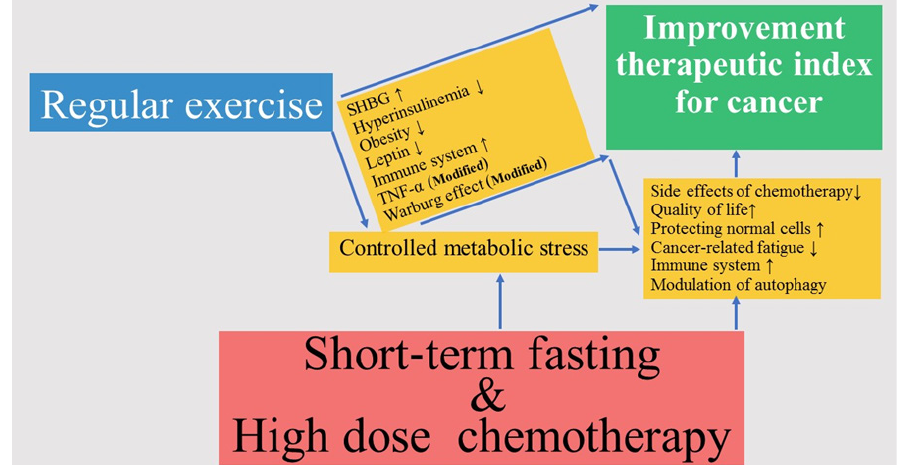
Figure 1. The Effect of Physiological Metabolic Stress Induced by Fasting or Exercise Rehabilitation on Improving Cancer Treatment